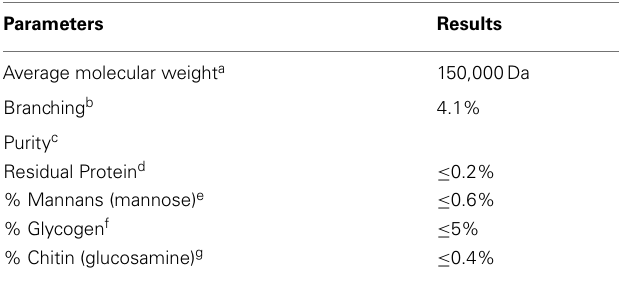
Table 2 |Analytical characterization of PGG β